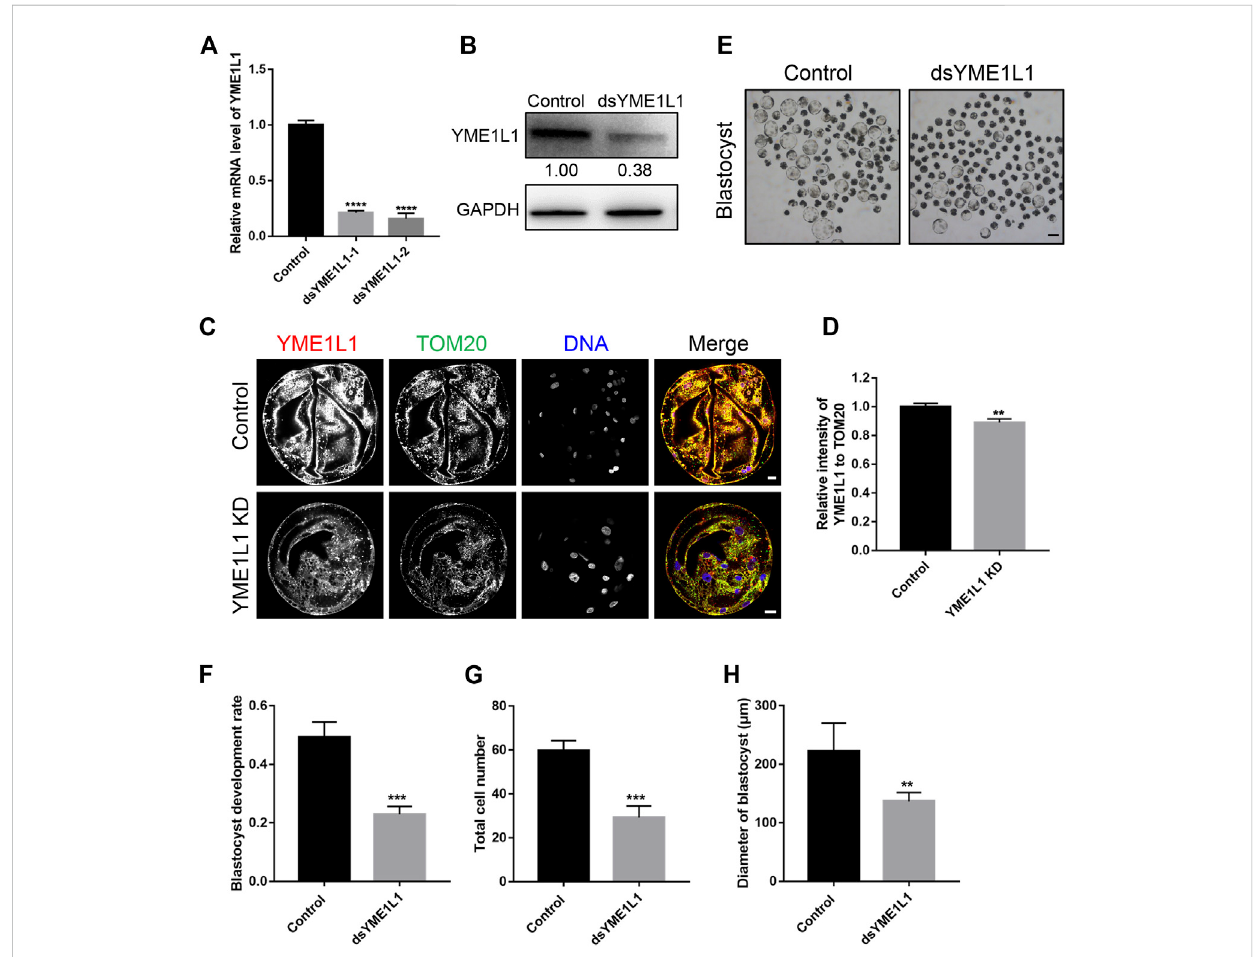
FIGURE 2 Effects of YME1L1 knock-down on embryonic development. (A) Quantitative PCR con fi rmed YME1L1 knock-down in the blastocyst stage embryos. (B) ProteinlevelsofYME1L1afterYME1L1knock-downattheblastocyststagebywesternblotanalysis. (C,D) Representativeimmuno fl uorescenceimages and relative intensity analysis of YME1L1 and TOM20 expression after YME1L1 knock-down at the blastocyst stage. (E) The morphology of the blastocyst stage embryos in both Control and YME1L1 KD groups. Scale bars, 100 μ m. (F) The blastocyst rate in YME1L1 KD and Control groups. (G) Total cell number of YME1L1 KD ( n = 25) and Control ( n = 20) embryos. (H) Blastocyst diameter in the Control ( n = 35) and YME1L1 KD ( n = 20) group. ** p < 0.01, *** p < 0.001 and **** p < 0.0001 were considered as signi fi cant